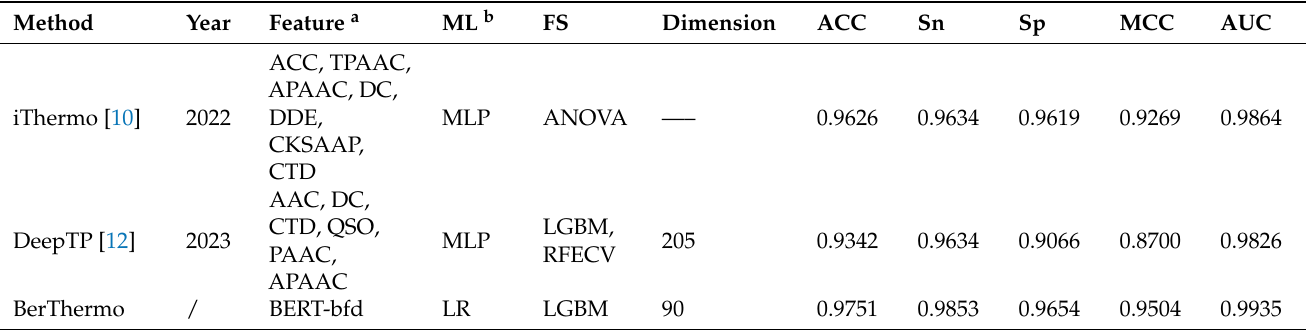
Table 4. Comparison of our model and previous models on independent test with a iThermo benchmark dataset.